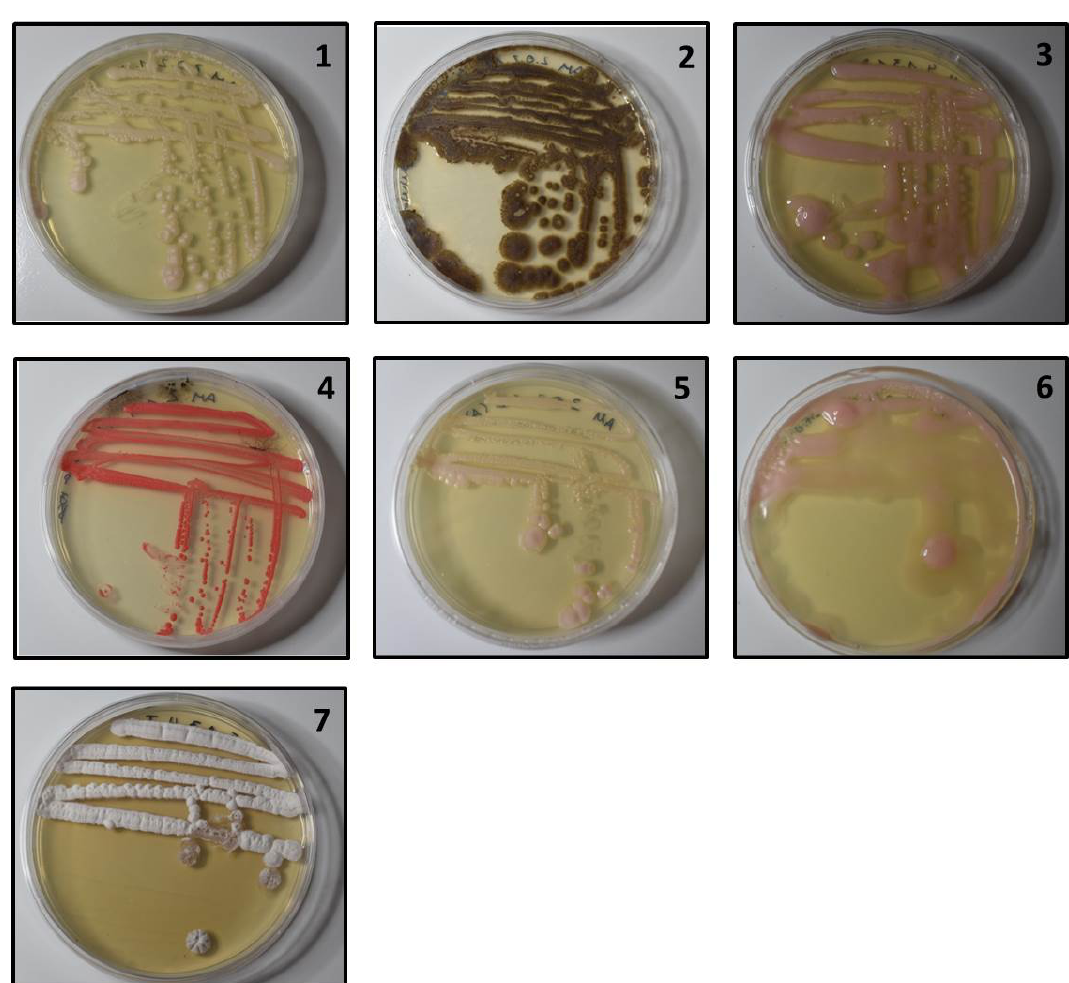
Figure 1. Morphology of isolated yeasts (seven